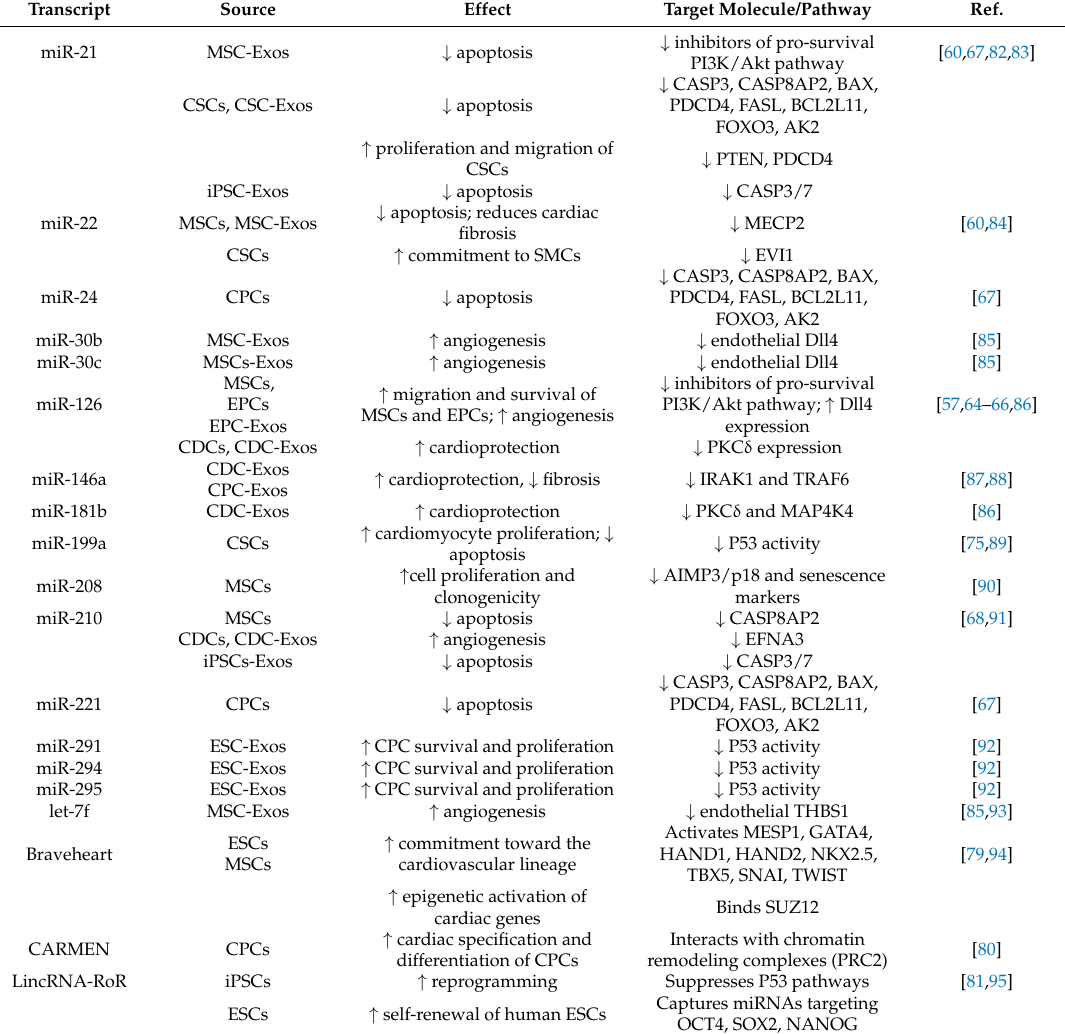
Table 3. Main non-coding RNAs expressed by SCs that regulate SC fate and